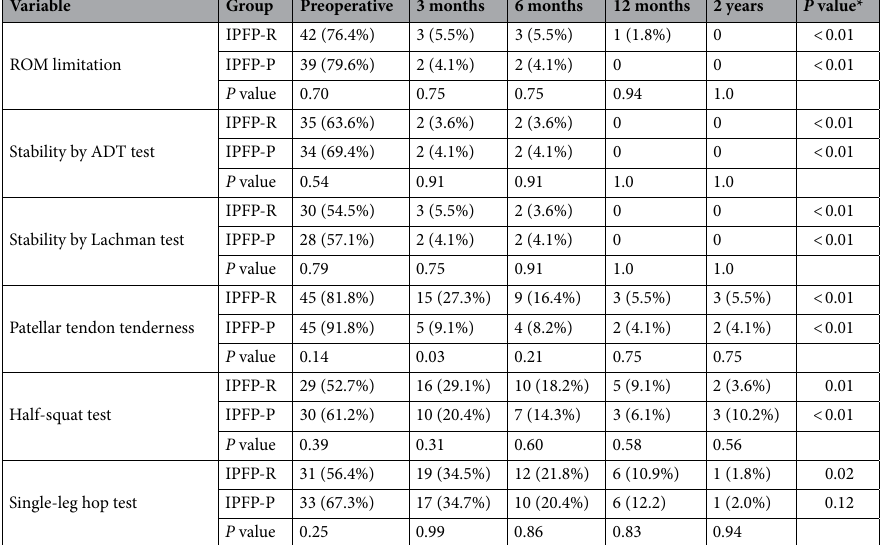
Table 3. Intergroup and intragroup comparison of knee joint activity before and after surgery in both groups. Values are expressed as n (%). Range of motion (ROM) limitation was defined as less than 10° of knee extension or flexion compared to the healthy side. IPFP-R infrapatellar fat pad resection, IPFP-P infrapatellar fat pad preservation, ROM range of motion, ADT anterior drawer test. *The P value was obtained from the comparison of preoperative and 3 months after